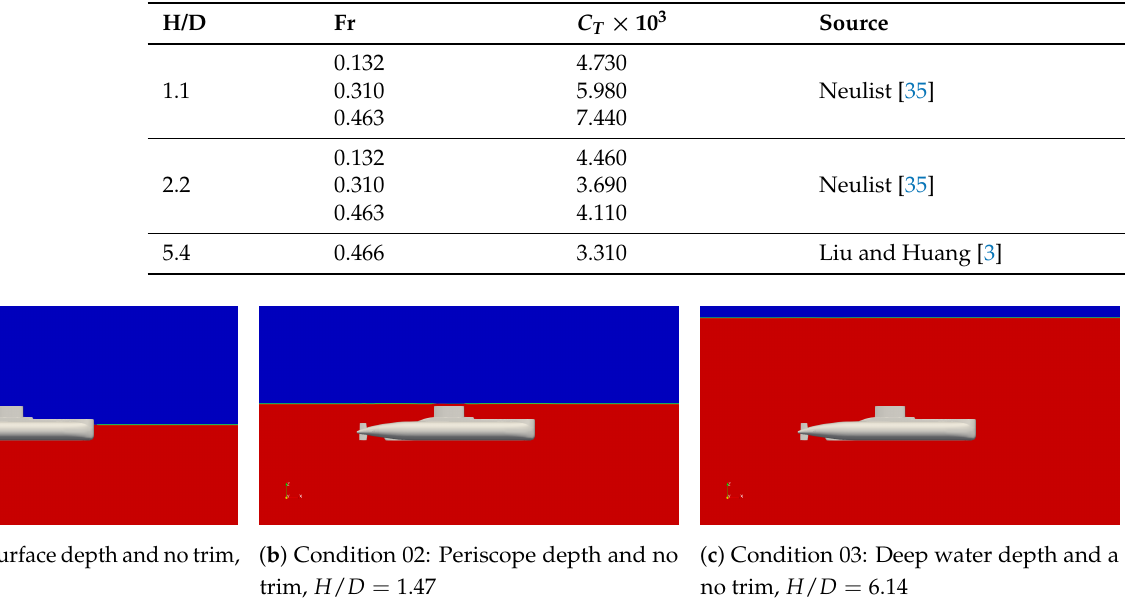
Figure 7. Navigation conditions considered for numerical simulations. Initial condition of alpha water distribution where red is water and blue is air.